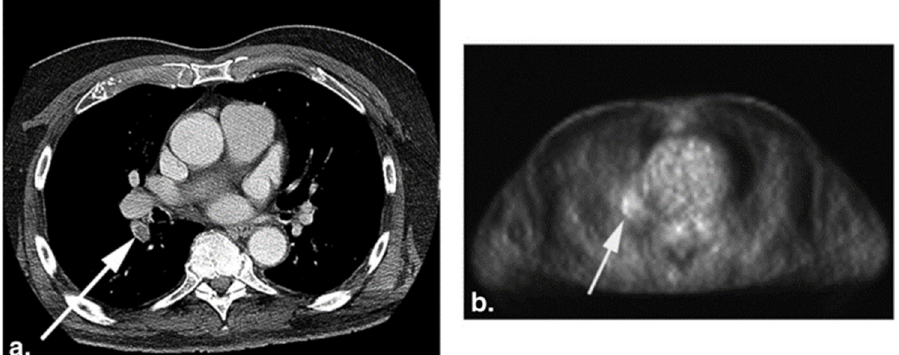
Figure 4. CT ( a ) and the corresponding FDG-PET ( b ) images of a 75-year-old woman with a history of melanoma. The white arrows point to pulmonary embolism (PE) present in the right lower lobe segmental artery. Increased FDG uptake ( b ) is seen at the location of PE on the PET image (from Flavell et al. [119] with permission).